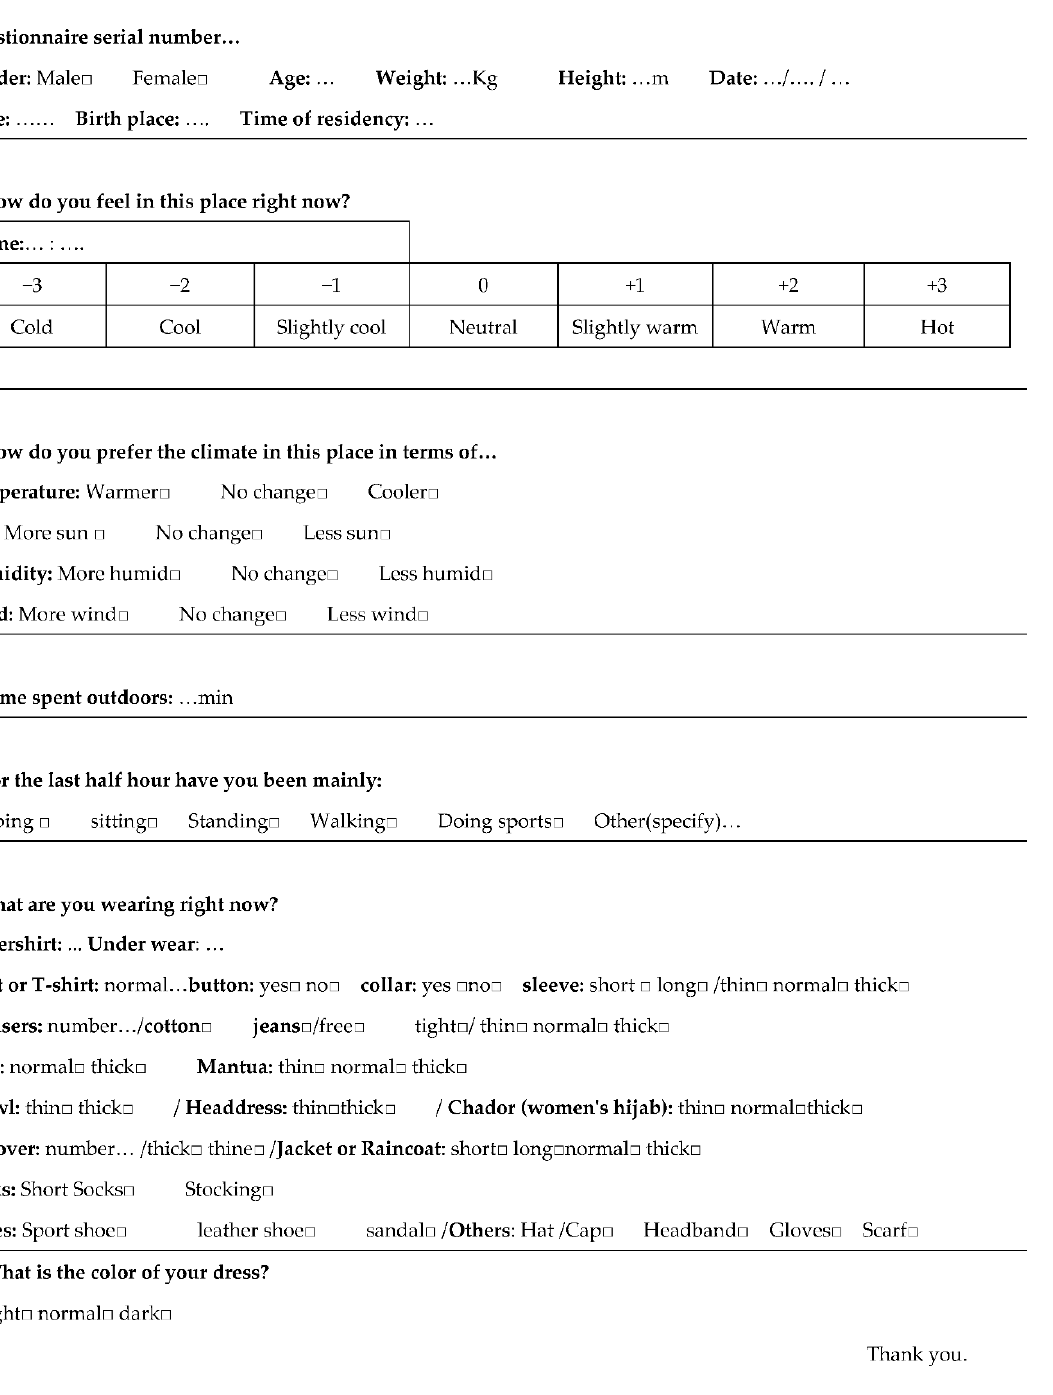
Figure 2. The questionnaire consists of six different parts, including personal information and their preferences during the survey. preferences during the